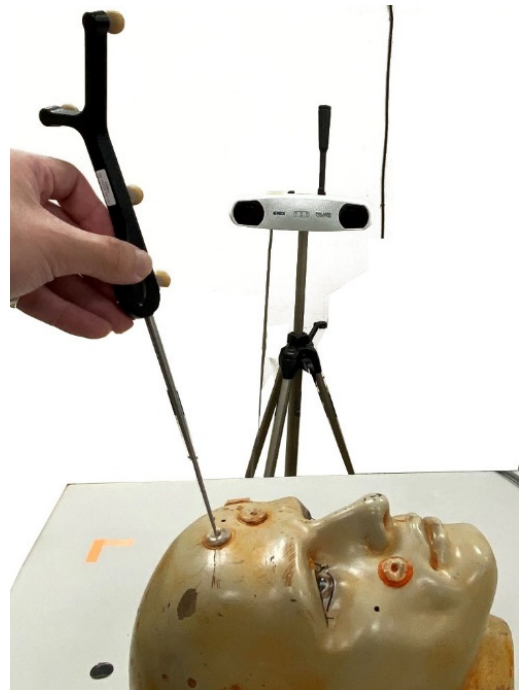
Figure 2. The hardware setup of the proposed system.